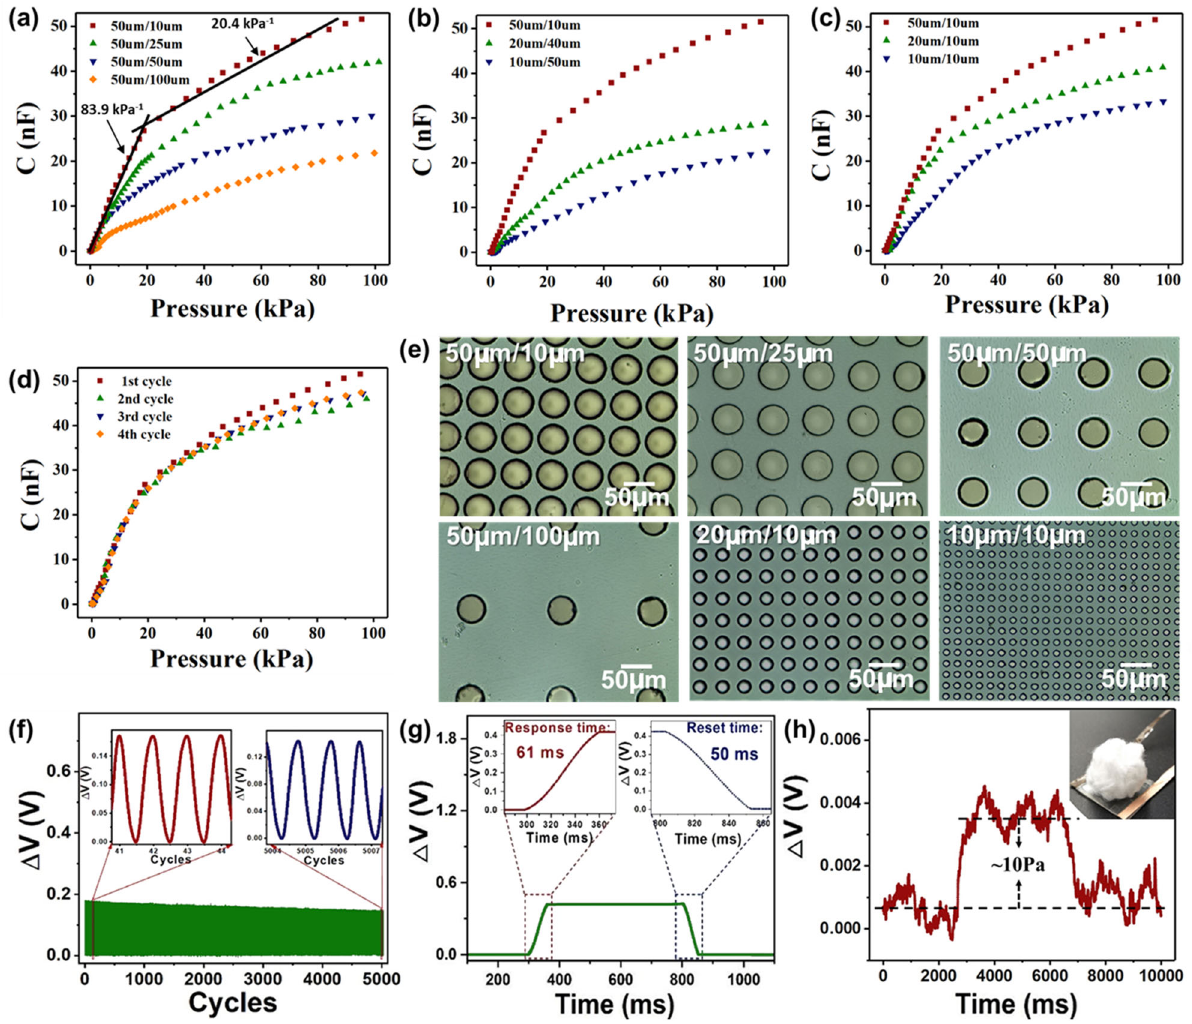
Fig. 3 The mechanical response of the TIS device. a The response ( C – P ) curves of the TIS devices using the ionic gels with different micro- hemispheric array densities, b the response ( C – P ) curves of the TIS devices using the ionic gels with different hemisphere diameters, c the response ( C – P ) curves of the TIS devices using the ionic gels with maximal density of the hemispheres at various feature sizes, d the repeatability of the response ( C – P ) curves of the TIS devices, e the microscopic images of the ionic gels with different surface topologies, f the characterization of the response and reset times in the dynamic loading test, g the repeatability test of 5000 cycles, and h the pressure resolution and detection threshold of the TIS